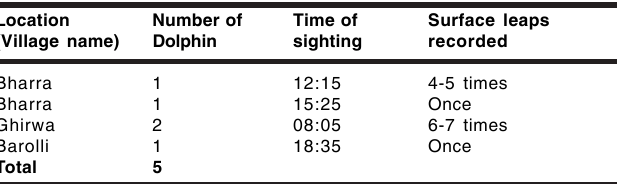
Table 1. Location of sightings of Gangetic Dolphin ( Platanista gangetica gangetica ) during Chambal River Expedition in 1998 in Rajasthan